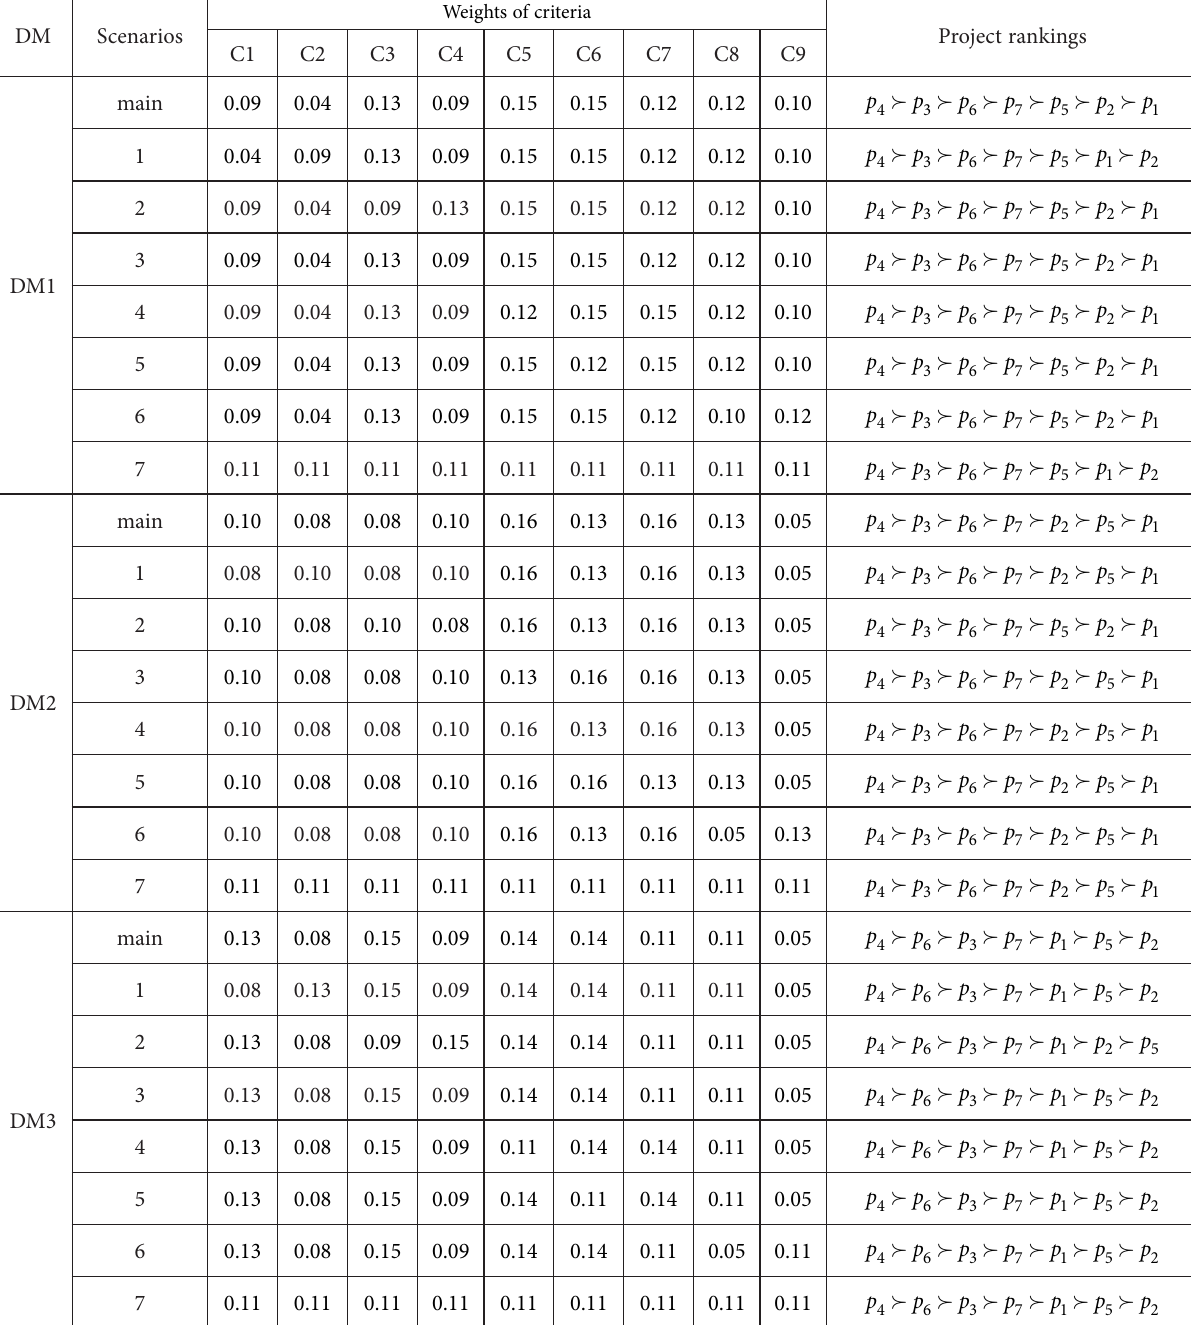
Table 9. Sensitivity analysis on weights of criteria by switching with each